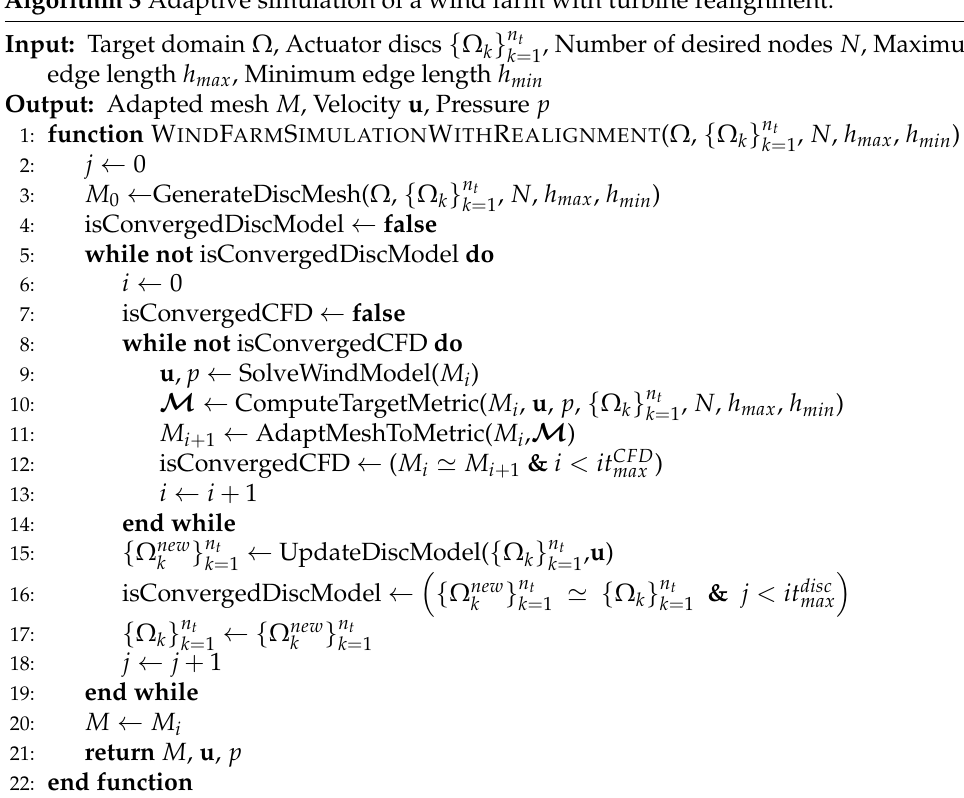
Algorithm 3 Adaptive simulation of a wind farm with turbine